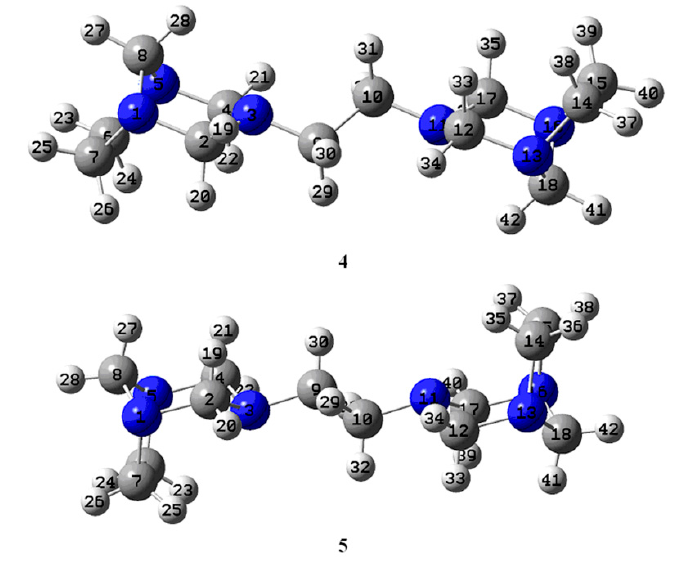
Figure 1. The optimized structures of exo ( 4 ) and endo ( 5 ) arrangement for ETABOC at B3LYP/6-31G(d,p) level.